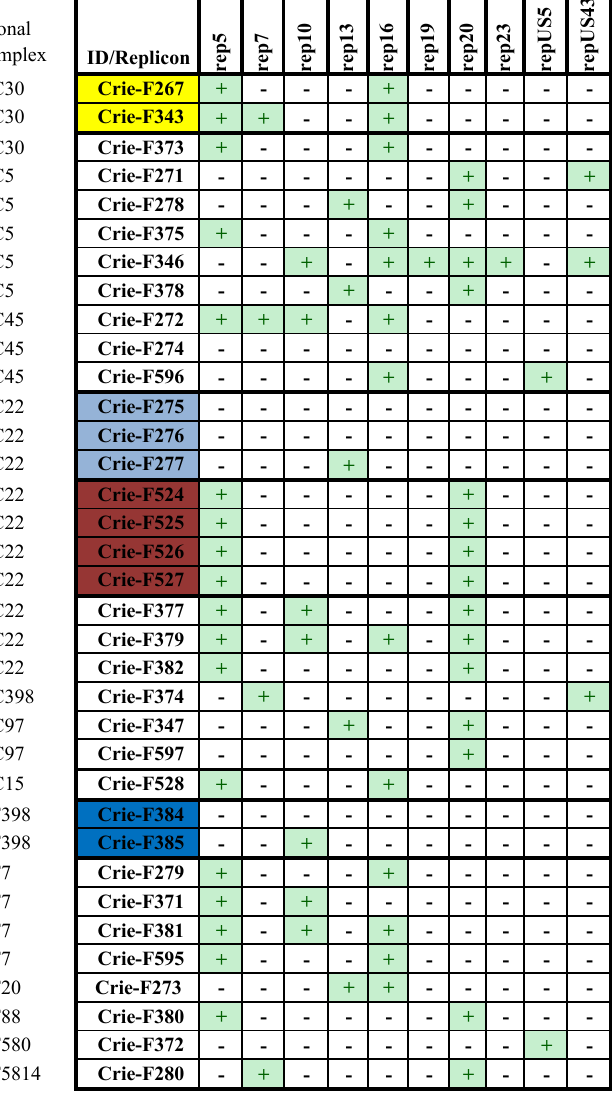
Figure 3. Plasmid replicon sequences profiles of RTE food S. aureus isolates studied. ‘+’ means that the given replicon is present in the isolate, ‘-‘ – that the replicon was not found. The isolates found to belong to the same strain are highlighted with